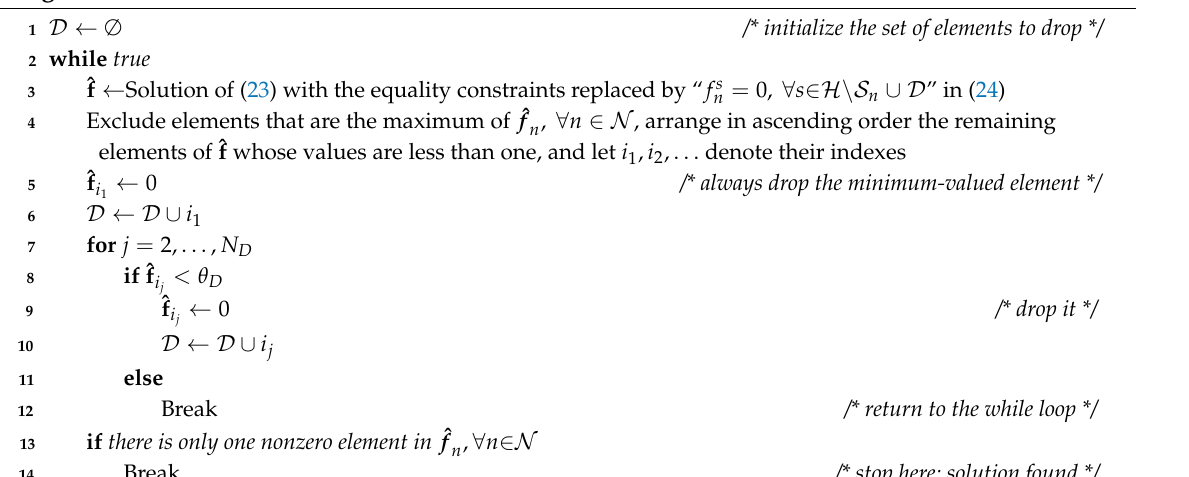
Algorithm 1: Successive convex